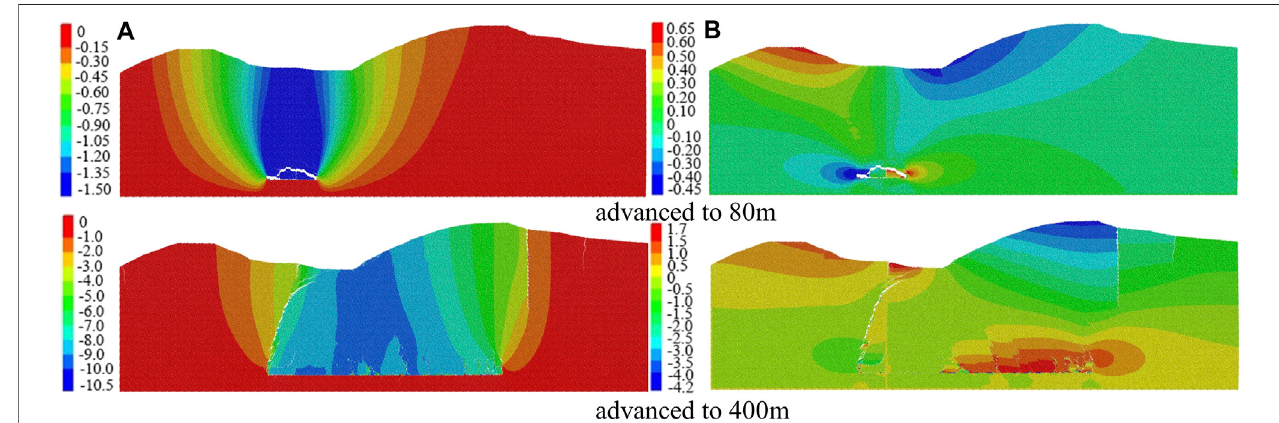
FIGURE 9 | Horizontal and vertical displacement caused by mining. (A) Vertical displacement(m). (B) Horizontal displacement(m).